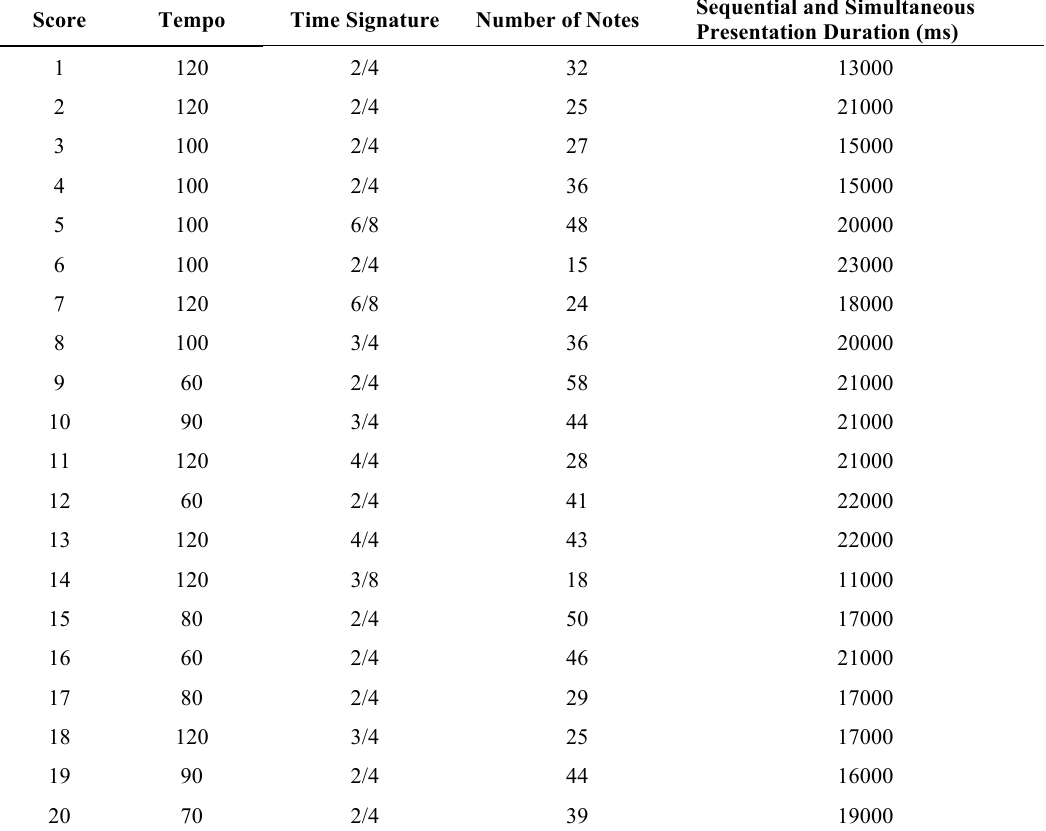
Table A1. Characteristics of the 20 applied melodies: tempo, time signature, number of notes and duration of visual presentation corresponding to the duration of auditory presentation (in sequential and simultaneous